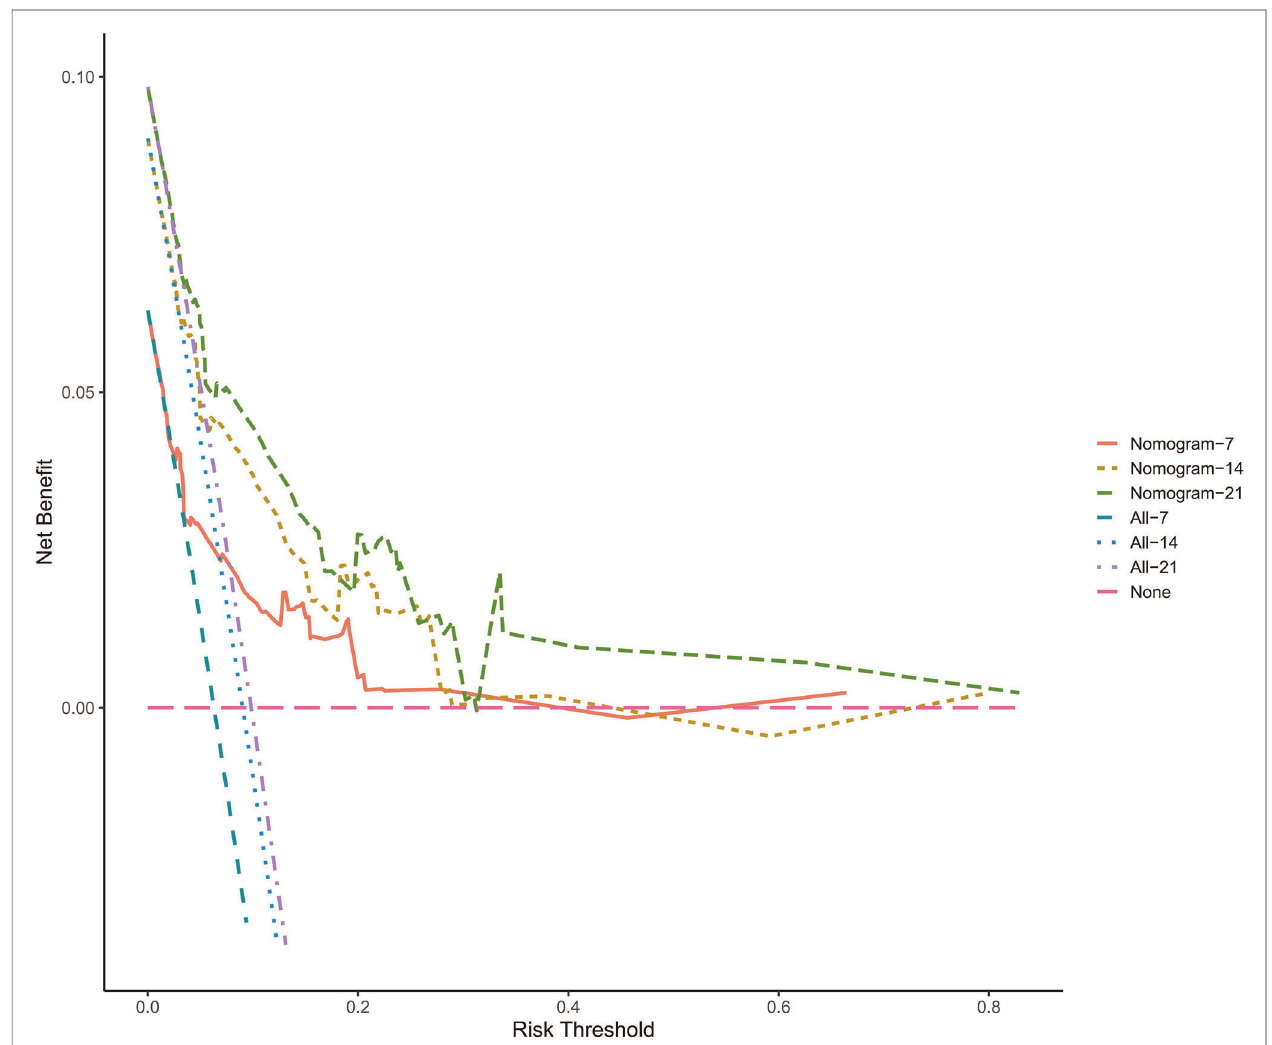
FIGURE 3 | The clinical decision curve for predicting the occurrence of DCI. The x -axis represents the threshold probabilities, and the y -axis measures the net bene fi t calculated by adding the true positives and subtracting the false